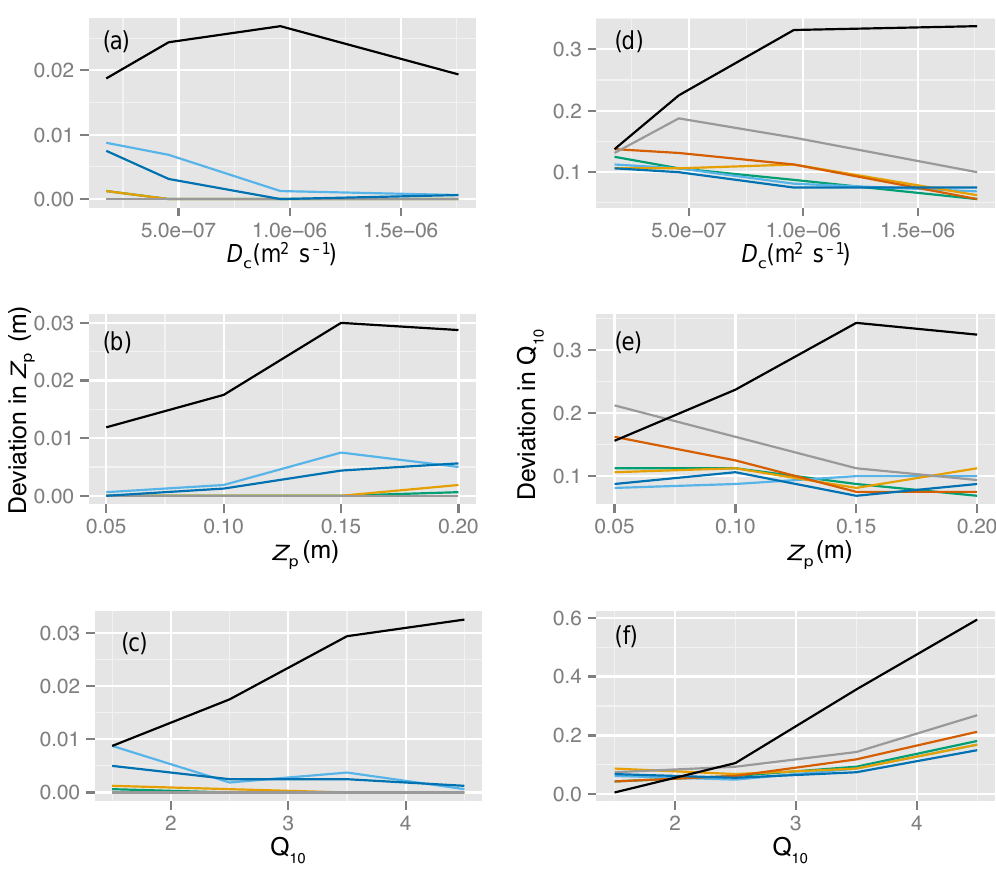
Figure 4. Error in Q 10 and Z p as a function of Q 10 (c, f) , Z p (b, e) and D c (a, d) , for a grouping of the best sensor measurement depth combinations. Individual 5 and 10cm observational scenarios are shown in light blue and dark blue, respectively. The 5 + 15cm measurement scenario is shown in green. Orange and red illustrate sensitivity of the 5 + 10 + 15 and 5 + 10 + 30cm scenarios, respectively. Finally, the 4-point 5 + 15 + 30 + 60cm measurement sensitivity is represented in grey while the surface-flux scenario is shown in black. For these sensitivity tests, the known Q 10 was 2.0, and a Z p of 0.2m was used.